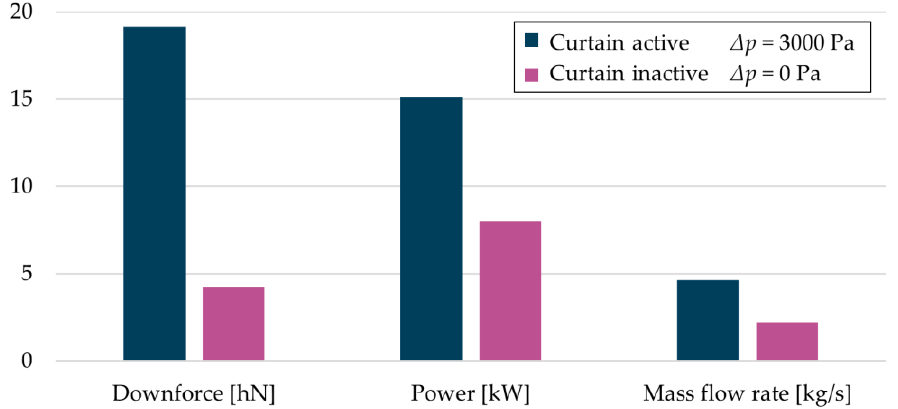
Figure 16. Comparison of operation parameters in the case with active curtain and curtain deactivated.